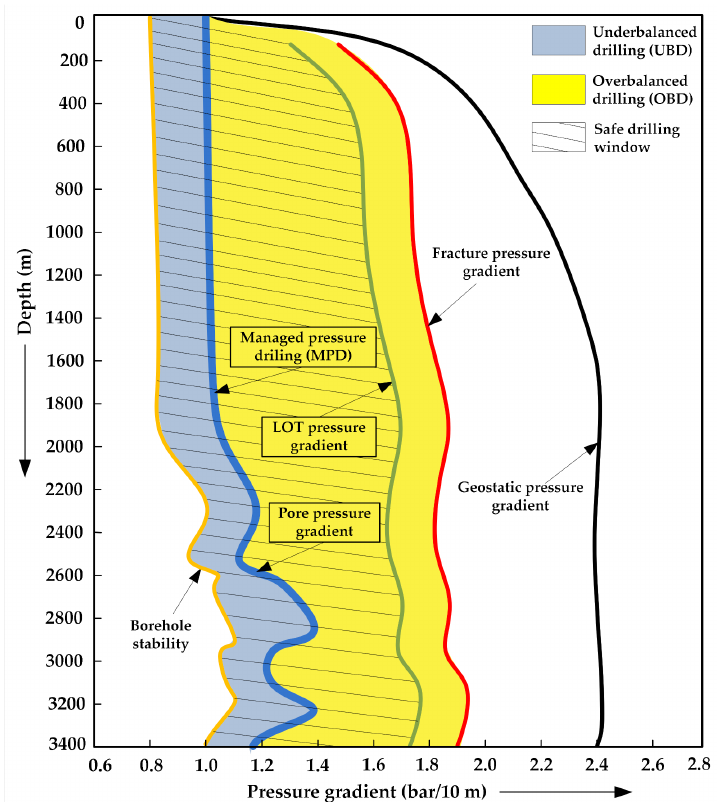
Figure 3. Comparison of pressure gradients and safe drilling